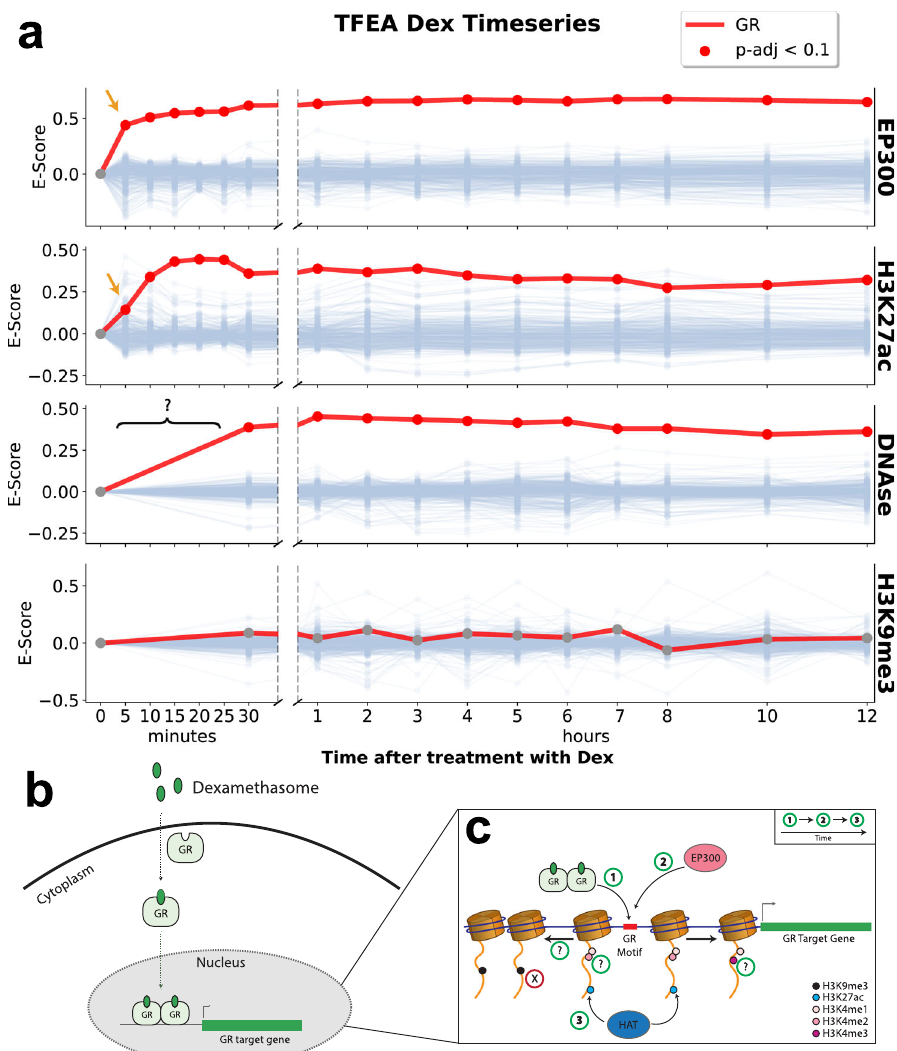
Fig. 6 TFEA captures rapid dynamics of the glucocorticoid receptor (GR) following treatment with dexamethasone. a TFEA correctly identi fi es GR (red line) from time-series ChIP data on the histone acetyl-transferase p300, H3K27ac, and DNase I 61 . No signal is observed in the negative control H3K9me3. TFEA shows a temporal lag in the H3K27ac signal (orange arrows). b Known cellular dynamics of GR induced by dexamethasone (Dex). c Mechanistic and temporal insights gained by performing TFEA analysis, question marks indicate datasets where earlier time points were not available to resolve temporal information. See Supplementary Data 1 for a complete list of accession numbers for